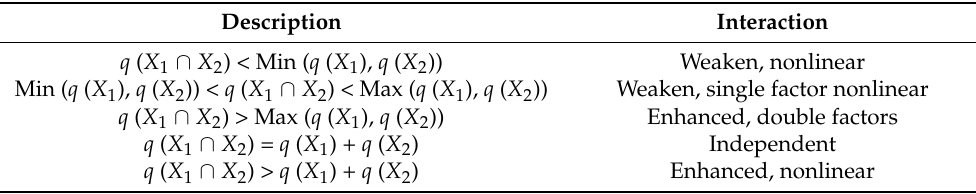
Table 1. Abstract example of types of interaction between two